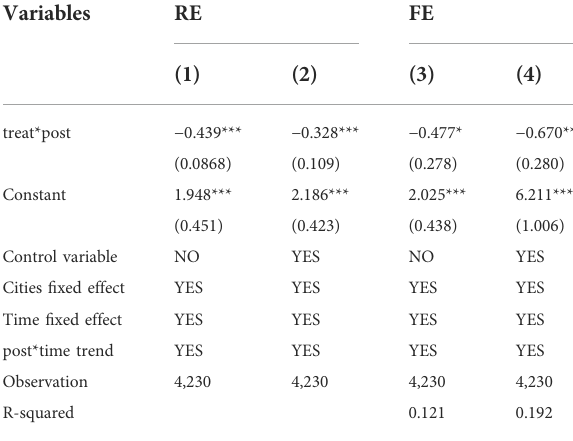
TABLE 8 Using per capita carbon